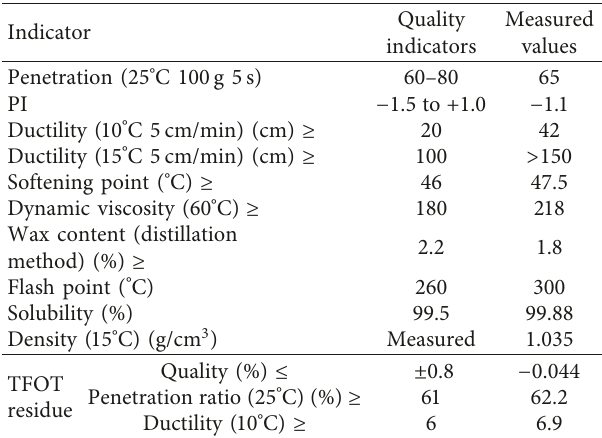
Table 2: Major technical indexes of